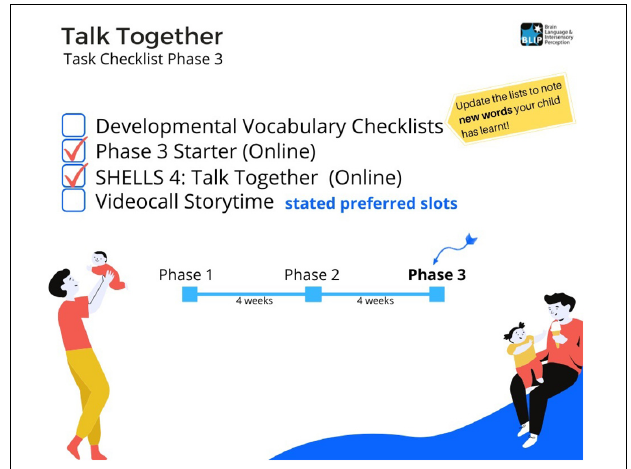
FIGURE 1 | Example of a visual progress checklist to help parents track their progress through tasks at a particular time-point.